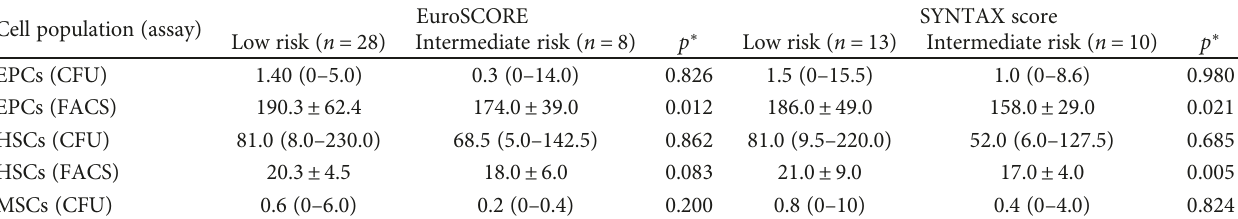
Figure 7: Odds ratio for the frequency and clonogenic potential of compartments of endothelial and hematopoietic stem cells. Table 3: Frequency of endothelial progenitor cells, hematopoietic stem cells, and mesenchymal stem cells in the sternal bone marrow samples from patients classi fi ed according to the EuroSCORE and SYNTAX score. Cells were analyzed by colony assay (CFU) and fl ow cytometry